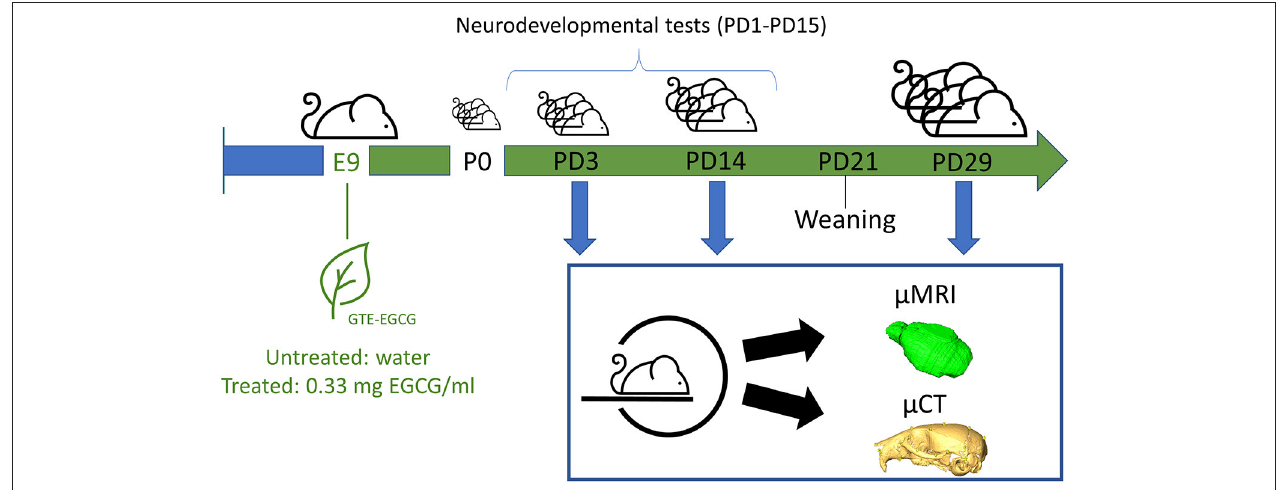
FIGURE 1 | Experimental overview. Ts65Dn mice were scanned in vivo from birth to juvenile stages, at three different stages of development [at postnatal day (PD) 3, at PD14 and at PD29] with µ CT to longitudinally follow the skeletal development and with µ MRI to follow brain development. Pups were tested daily from PD1 until PD15 for the appearance of developmental traits and reflexes related with their neurobehavioral development. Half of the litters were treated with GTE-EGCG at a concentration of 0.33mg EGCG/mL resulting in a dose of ∼ 100 mg/kg/day.